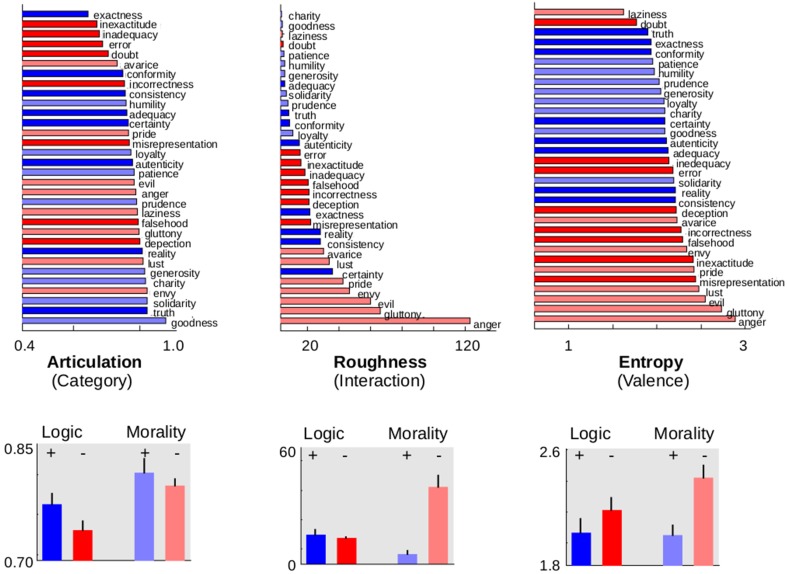
Musical, structural, and acoustical parameters for morality/logic concepts. Organization of musical improvisations for three parameters, where blue codes improvisations elicited by positive logic words, light blue for positive morality, red for negative logic, and light red for negative morality. The upper panels show the relative ordering of the presented words, averaged across pianists. The lower panels show mean values and standard deviations averaged across words and pianists. Articulation (left panels) is the only dimension to significantly discriminate the morality and logic categories (light from dark tones). This parameter varies between 0 (for staccato, notes separated by silences) and 1 (for legato, no breaks between notes). Roughness (middle panels) is the only dimension showing a significant interaction, discriminating valence for morality and not for logic words. Its range goes from 0 for a pure sine wave (no partial beats) to over 400 for white noise. On the other hand, entropy (right panels) is one of the parameters that significantly discriminate valence (blues from reds). Entropy of a single repeated note is 0 and its value increases for uniformly distributed notes. The mean values of the rest of the parameters can be found at Table 1 and Figure S2.